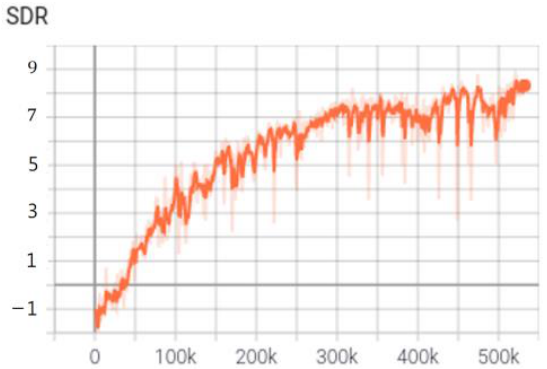
Figure 13. The related SDR value with the amount dataset of 921 people.